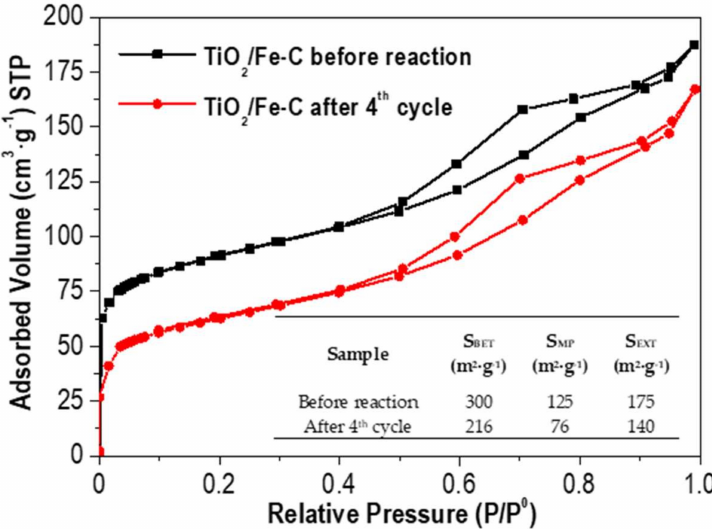
Figure 9. N 2 adsorption-desorption isotherms ( − 196 ◦ C) of TiO 2 /Fe-C before reaction and after four consecutive cycles. Surface area values of the photocatalyst are also included in the embedded